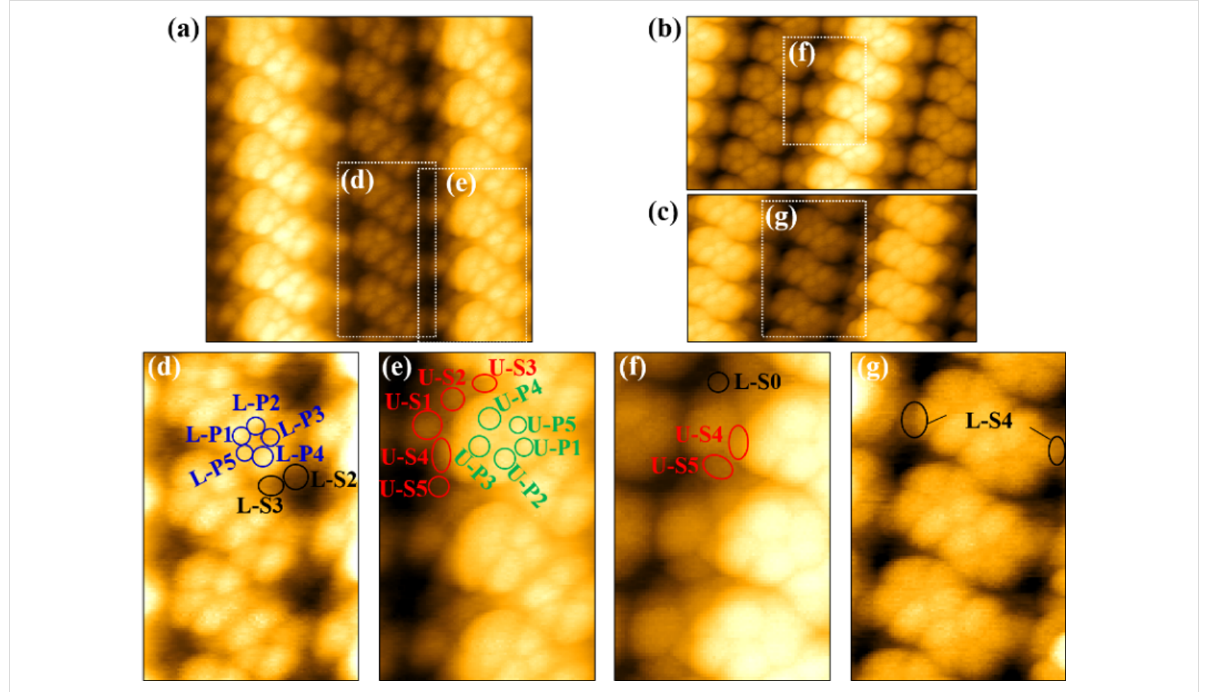
Figure 2: (a) Atomic-resolution AFM image (8 × 8 nm 2 ) of the 16×2 reconstruction area shown in Figure 1 ( f 0 = 162.5 kHz, A = 5 nm, V s = 0 mV, T = 78 K, Δ f = 18 Hz). (b), (c) AFM images of the 16×2 reconstruction, with a noticeably different appearance compared to (a) at the step edge ( f 0 = 162.0 kHz, A = 5 nm, V s = 200 mV, T = 78 K, Δ f = 17 Hz). (d), (e), (f), (g) Enlarged images of (a), (b), and (c), indicated by white squares. The observed bright spots are marked with colored circles. The bright spots in the pentagonal structure are labeled as P1 to P5, and those at the step edge are labeled as S0 to S5. U- and L- denote those on the upper and lower terraces, respectively.